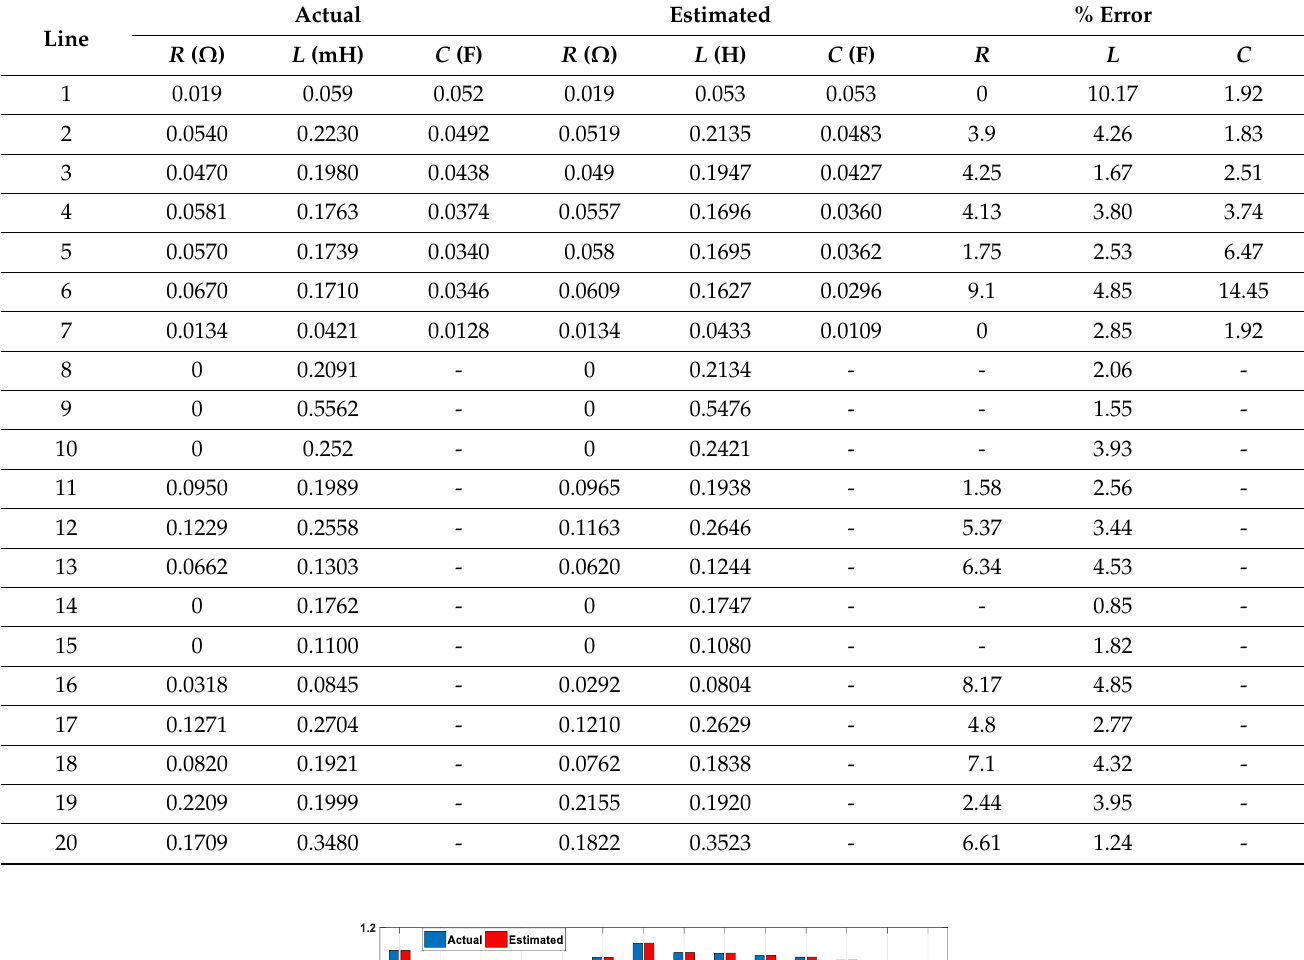
Table 4. Actual and estimated parameters of the 20 TLs of the IEEE 14-bus system from case study-3.